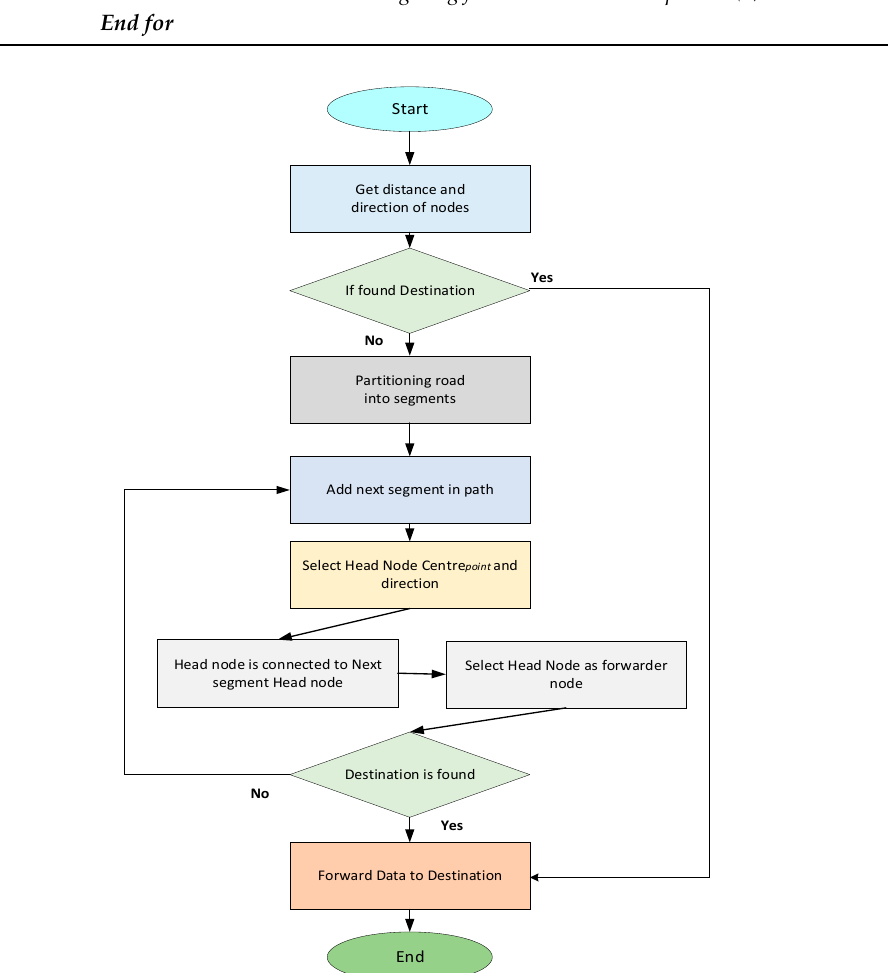
Figure 3. Flowchart of information dissemination-centric routing process.